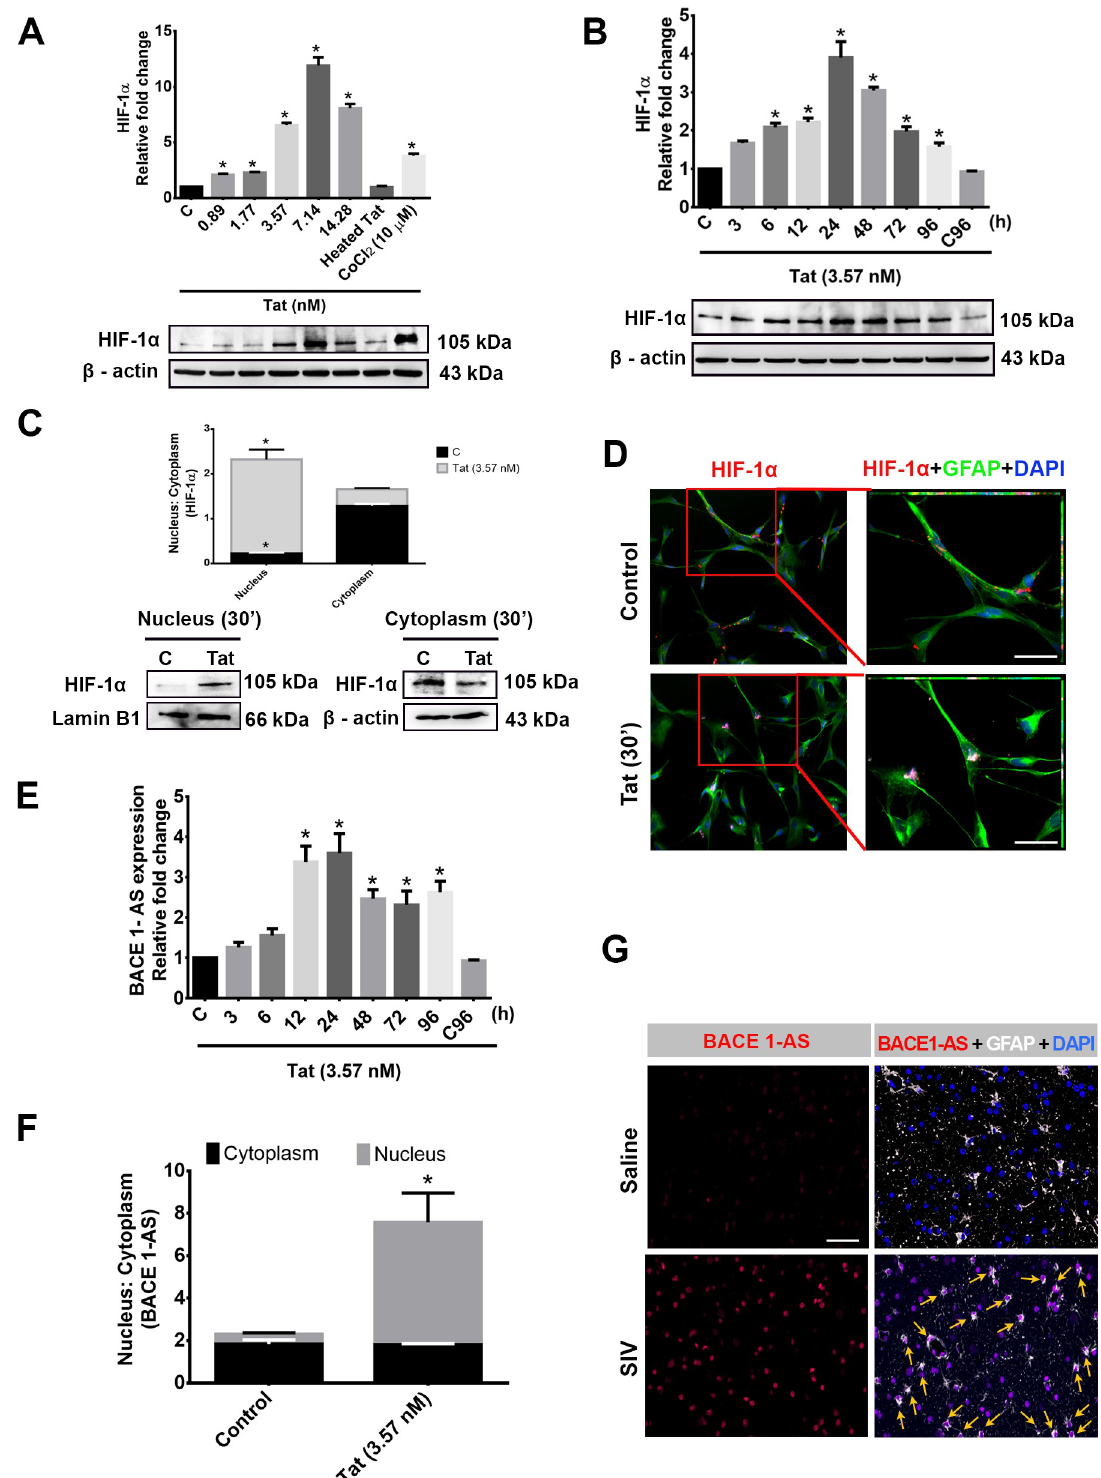
Fig 6. HIV-1 Tat–mediated expression of HIF-1 α and BACE1-AS in HPA. Western blot analysis showing dose- (A) and time- dependent (B) up-regulation of HIF-1 α in HPAs exposed to HIV-1 Tat at the indicated dose and time points. Cobalt chloride (CoCl 2 − 10 μ M) was used as a positive control for HIF-1 α expression. (C) Nuclear and cytoplasmic expression of HIF-1 α protein 30 minutes following exposure of cells to HIV-1 Tat (3.57 nM). (D) Representative fluorescent photomicrographs showing increased